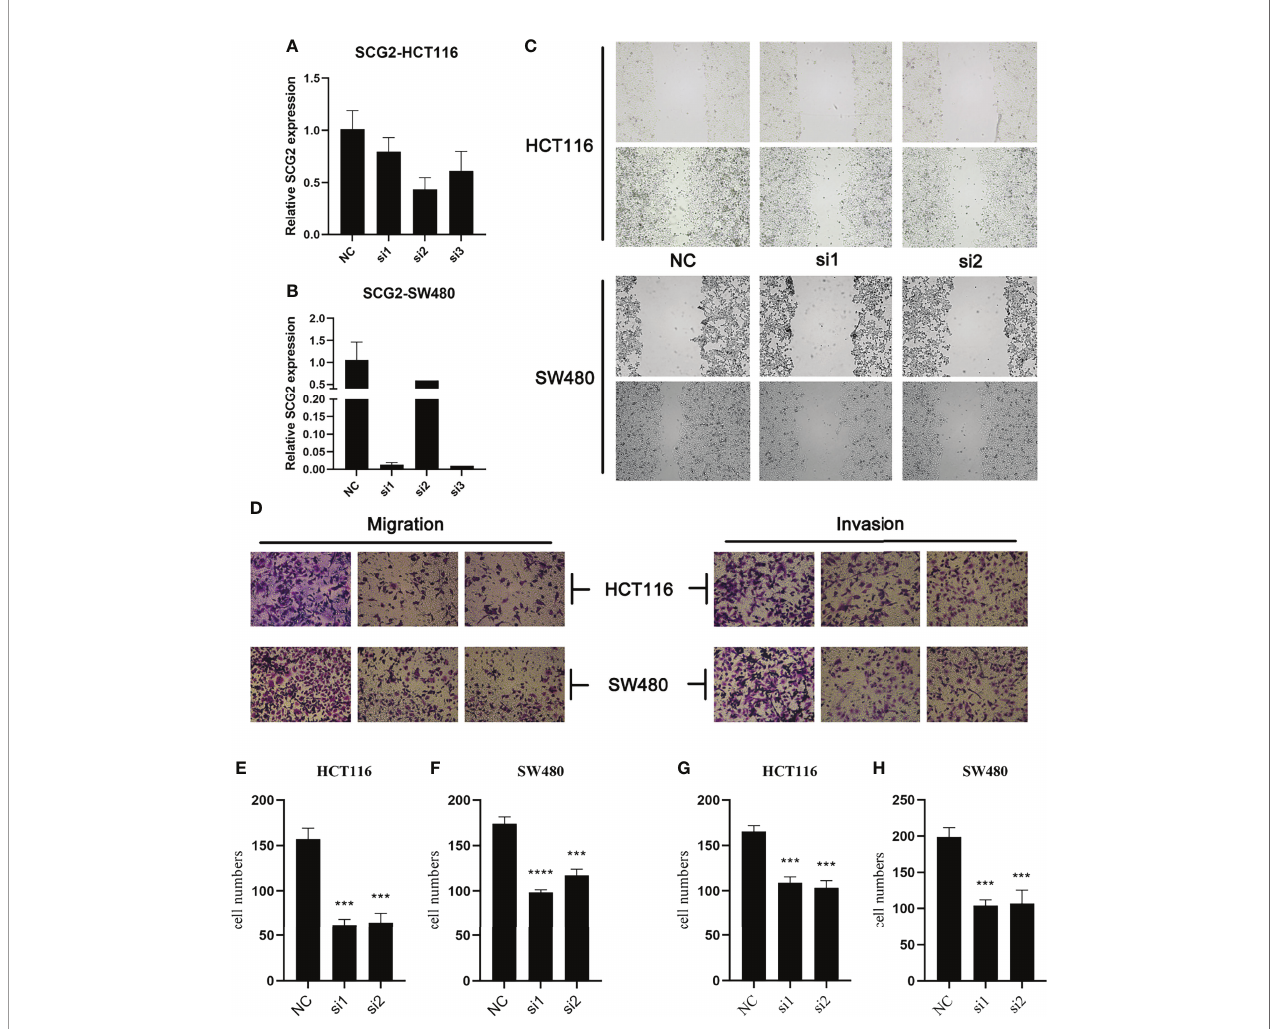
FIGURE 5 | Effects of SCG2 on CRC cells migration and invasion. (A, B) Expression was signi fi cantly reduced after SCG2 knockdown in in HCT116 (A) and SW480 (B) cell lines. (C) Wound-healing assay to detect the migratory ability of CRC cells in the control group and SCG2 downregulation group. (D) Transwell assay to detect the migratory and invasive ability of CRC cells in the control group and SCG2 downregulation group. (E – H) SCG2 knockdown signi fi cantly inhibits migration and invasion behavior in HCT119 (E, G) and SW480 (F, H) cell lines. *** P < 0.001; **** P <